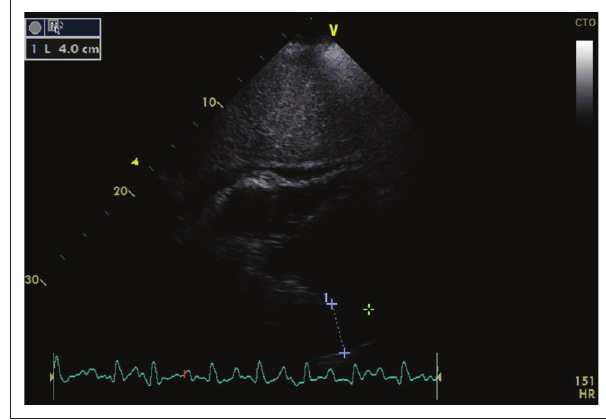
FIGURE 4: Echocardiography image of re-accumulation of pericardial fluid